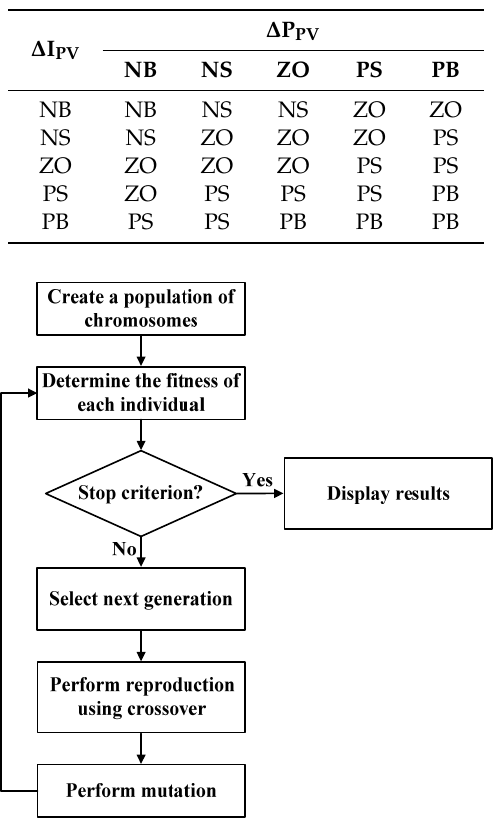
Figure 4. Flow chart of the genetic algorithm.